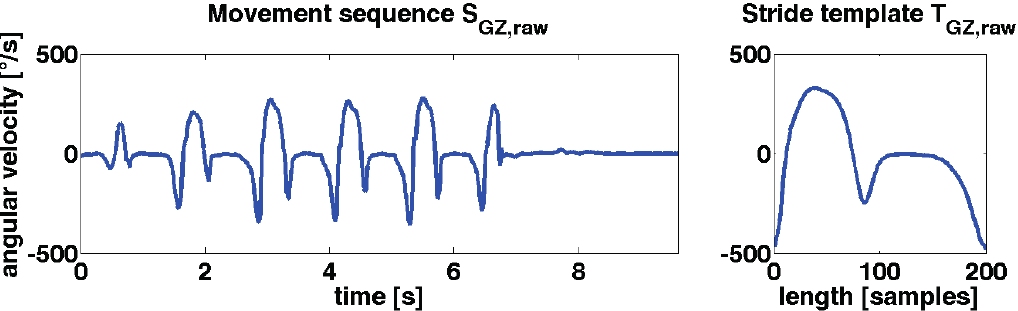
shows a typical angular velocity (cid:3008)(cid:3027),(cid:3045)(cid:3028)(cid:3050)